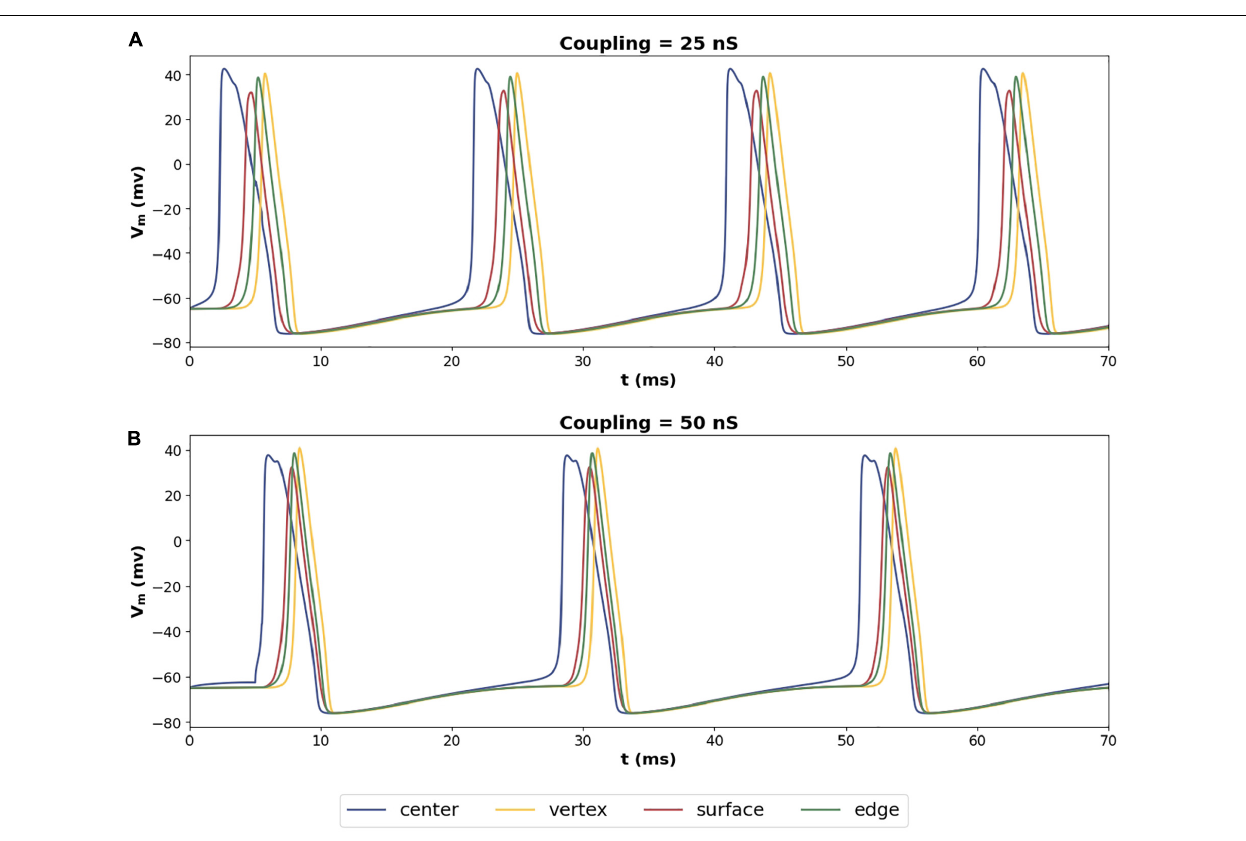
FIGURE 9 | Propagation of action potentials in a syncytium of size 5-cube with an oscillator cell placed at the center of the syncytium. The colors of the traces correspond to the cells highlighted in Figure 8A . Panel (A) shows the syncytial response with gap junctional coupling strength of 25 nS, and panel (B) shows the same with 50 nS. These values correspond to the mid and max values plotted in Figure 8B